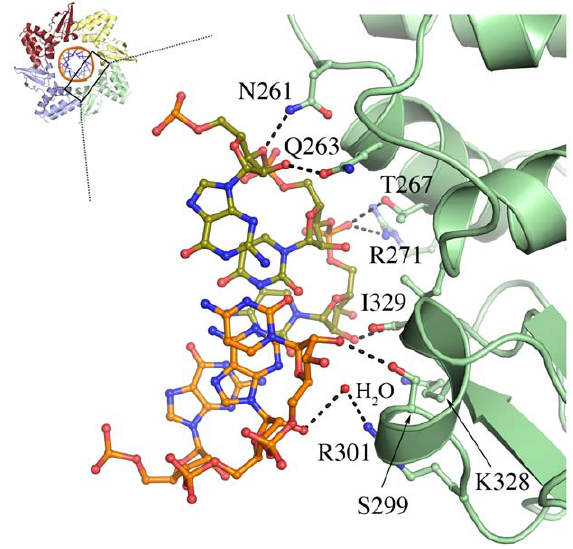
Figure 3. Key interactions of MARV VP35 RBD with dsRNA. dsRNA is shown in ball-and-stick representation. Hydrogen bonds are shown as black dotted lines. A bridging water molecule is shown as a red sphere. A representative MARV VP35 RBD is drawn in pale green.